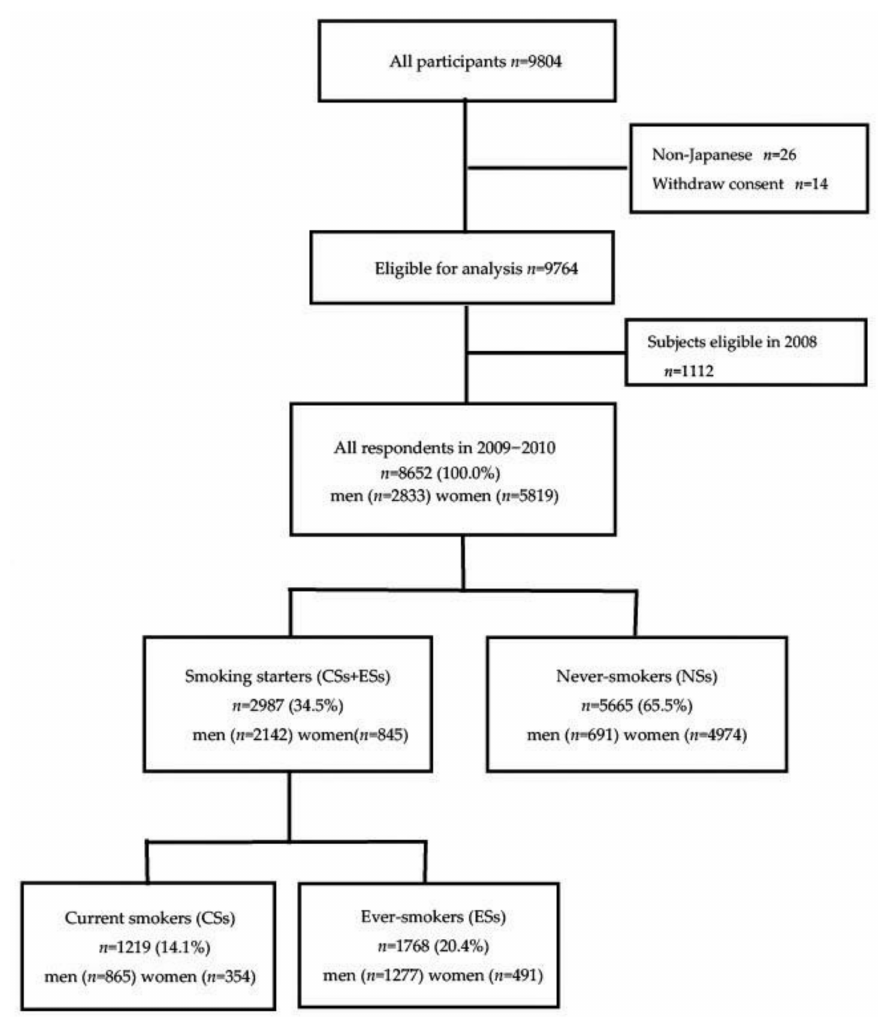
Figure 1. Participant flow